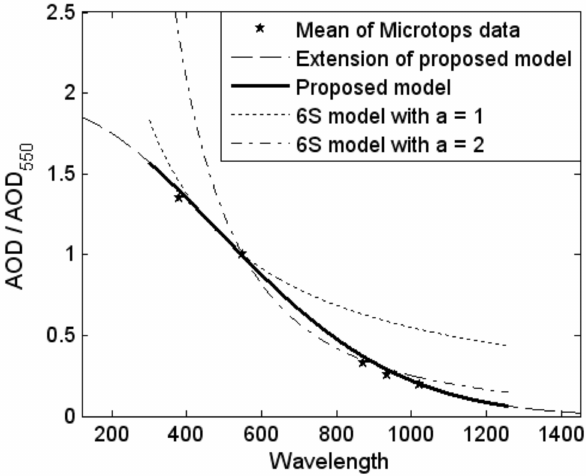
Figure 5. Comparison of average relative AOD to its value at 550 nm with 6S and proposed